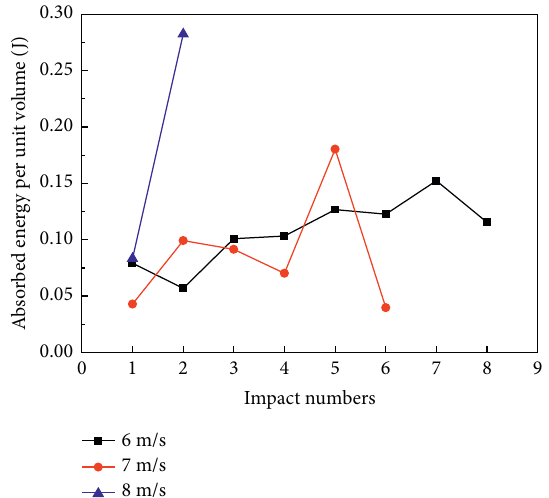
Figure 11: Variation of sandstone absorbed energy per unit vol- ume along with impact numbers.